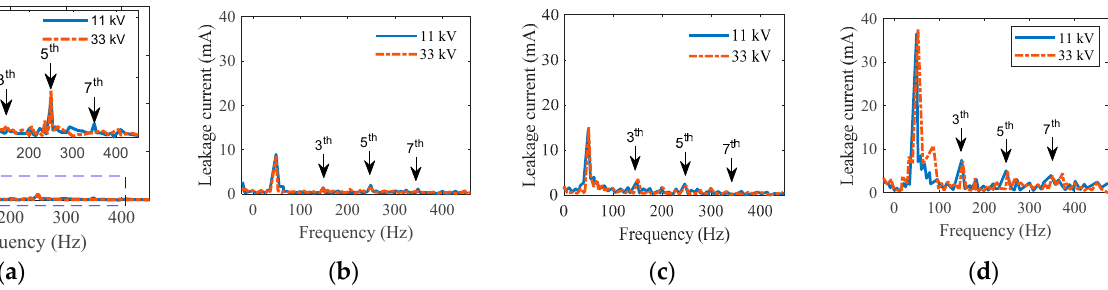
Figure 7. FFT of leakage current waveform under NSDD = 0.15 mg/cm 2 , Wt = 3 mL/h and different SDD: ( a ) SDD = 0.00 mg/cm 2 ; ( b ) SDD = 0.05 mg/cm 2 , ( c ) SDD = 0.12 mg/cm 2 , ( d ) SDD = 0.2 mg/cm 2 .